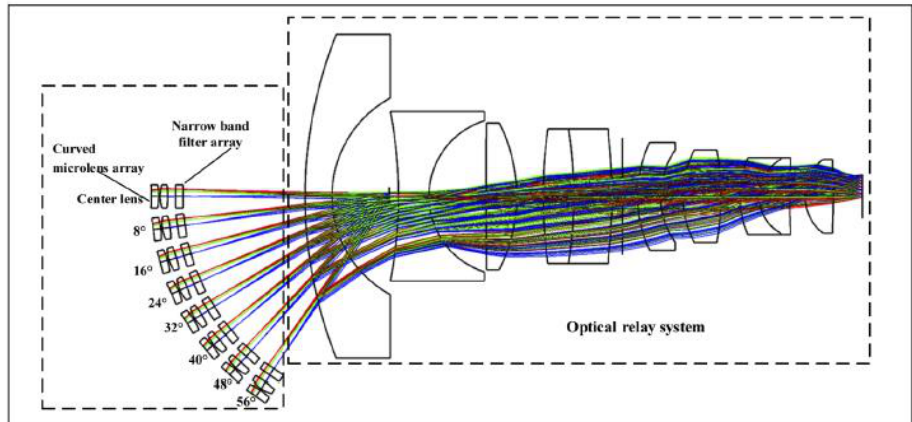
Figure 48. Optical design for the MCCEC system.